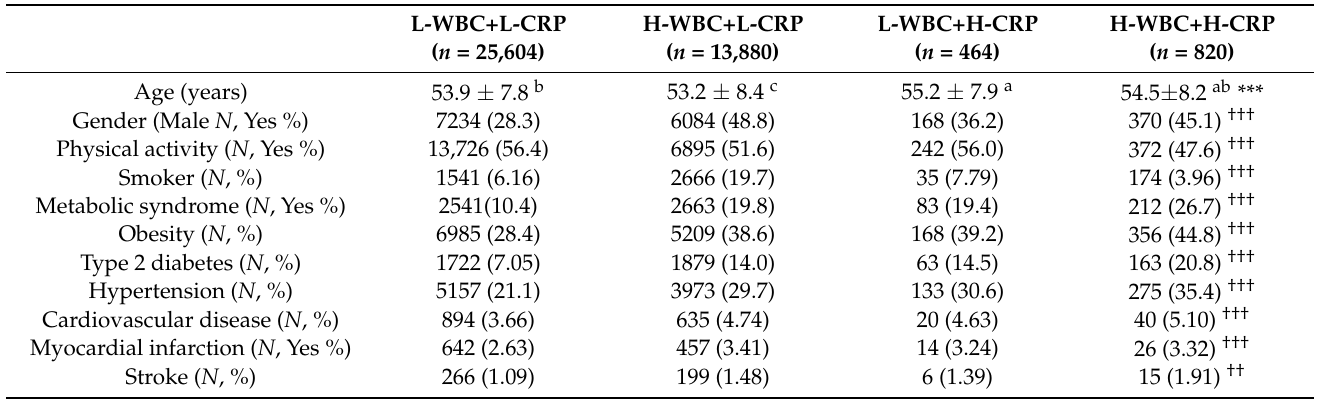
Table 1. General characteristics and frequencies of various diseases of the participants according to immunity